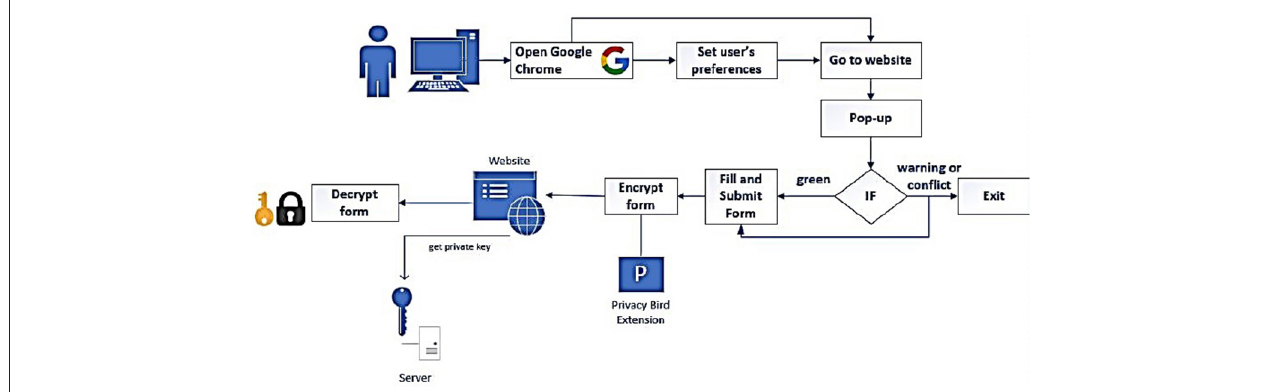
FIGURE 1 | Extended APEX